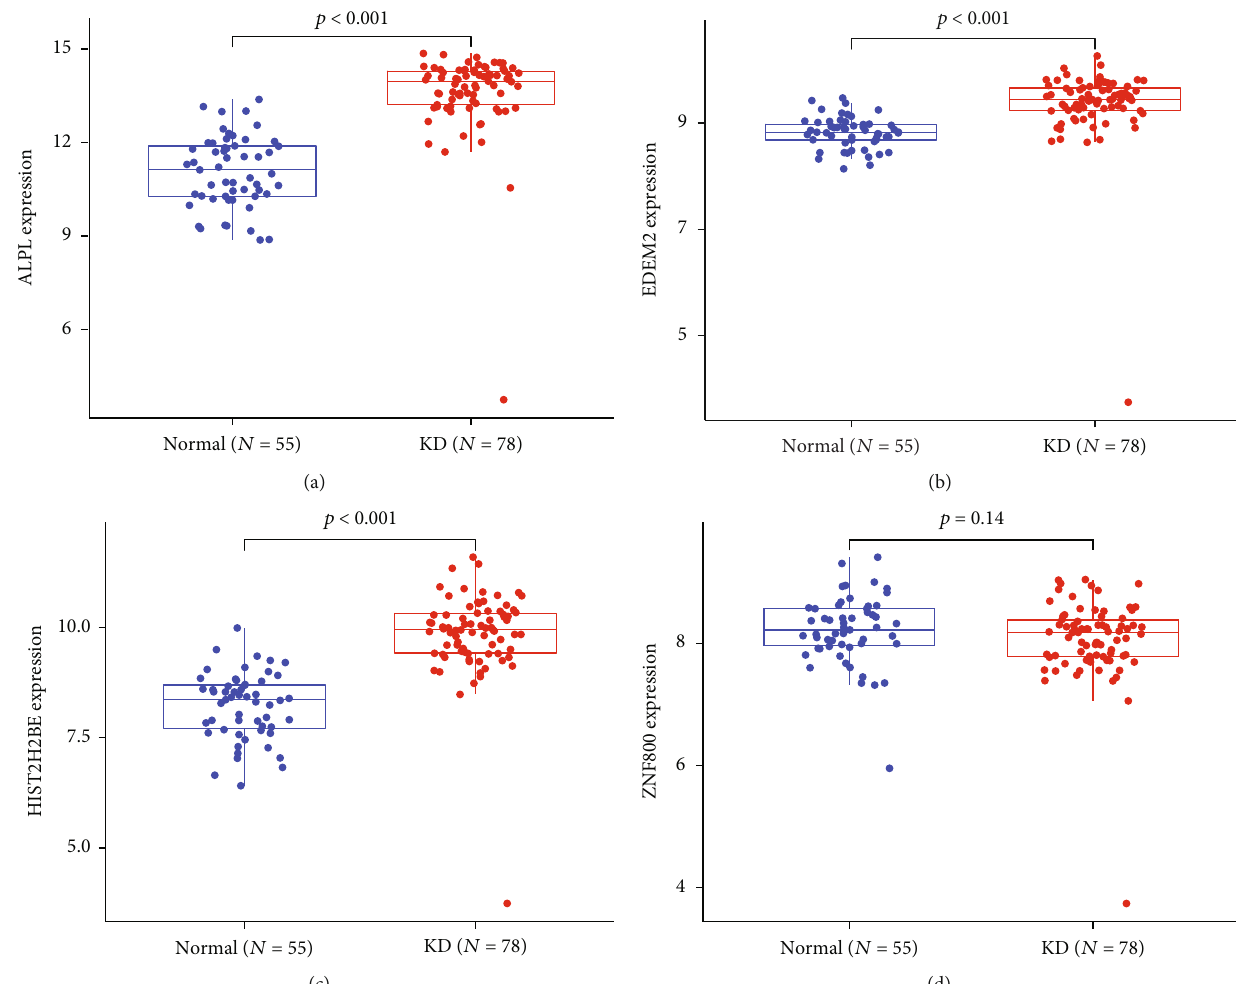
Figure 4: Validation of the expression of diagnostic biomarkers in the GSE73461 dataset. (a) ALPL, (b) EDEM2, (c) HIST2H2BE, and (d)